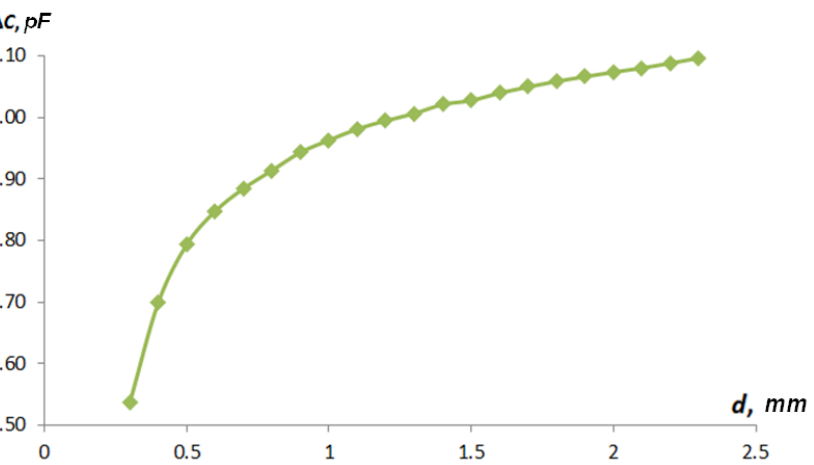
Figure 15. Graphs of the influence of the fringe effect on the total capacity of the distance to the grounded control object for the type 1 sensor.